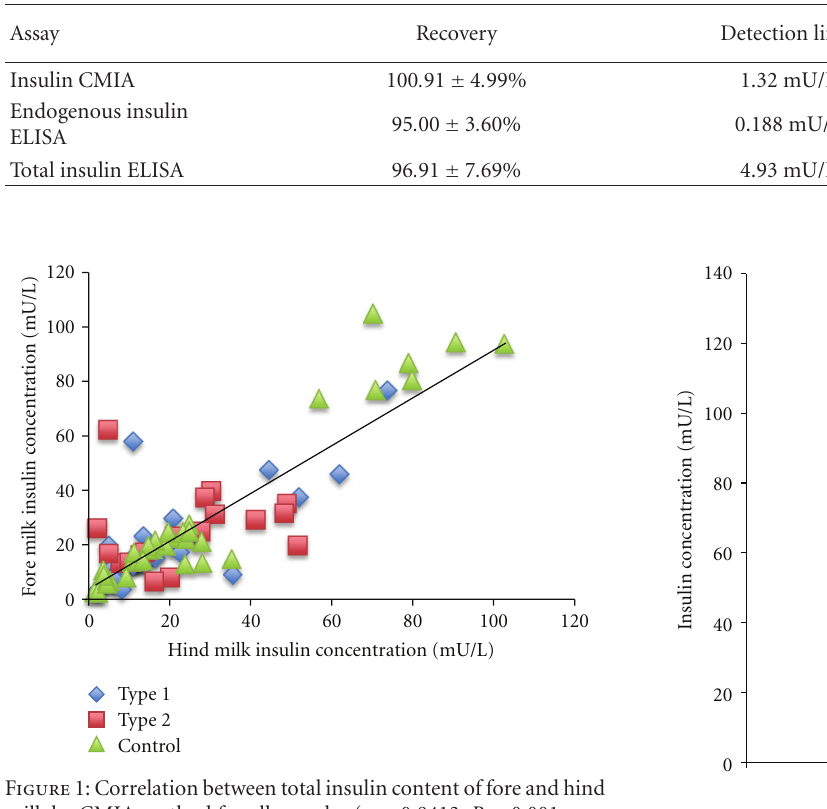
Figure 1: Correlation between total insulin content of fore and hind milk by CMIA method for all samples ( r = 0 . 8413, P < 0 . 001, n = 199 all fore + hind milk samples).